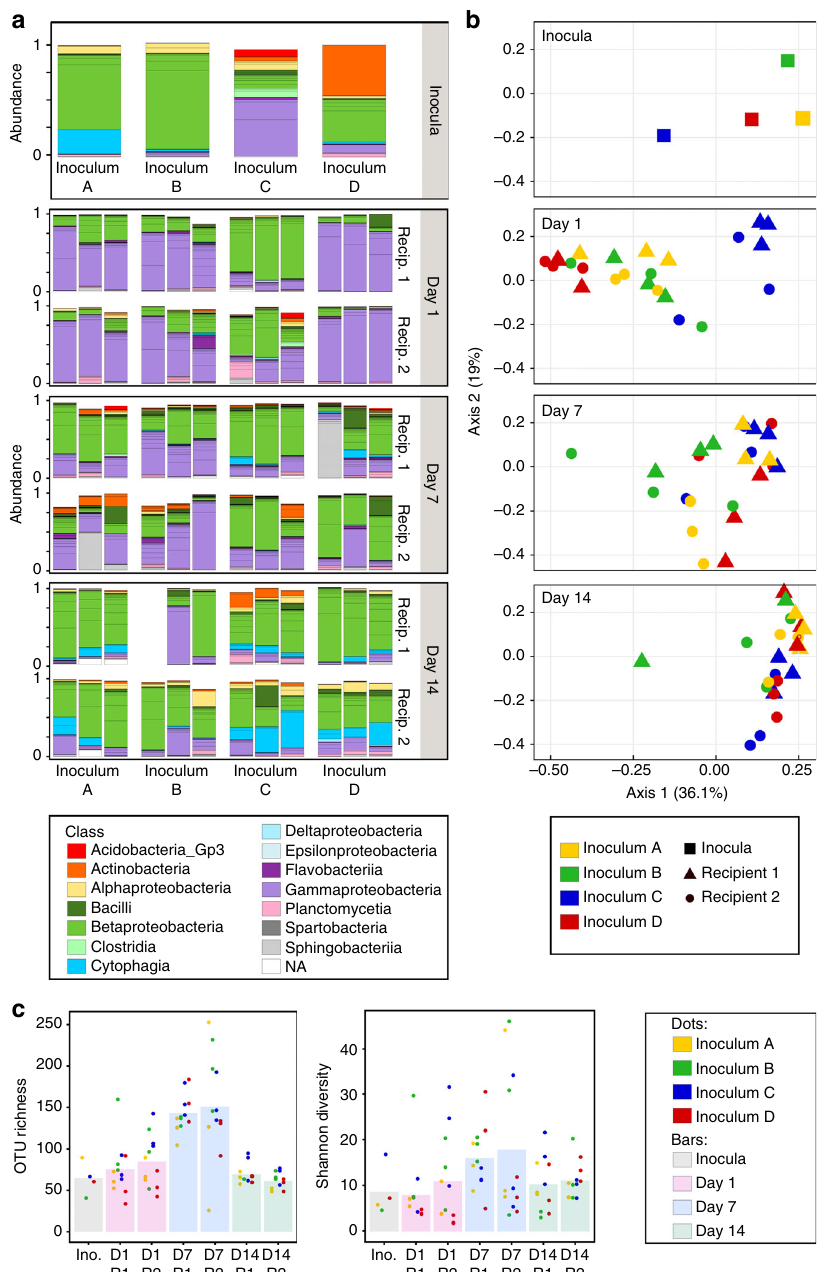
Fig. 5 Host genotype and initial bacterial inoculum interact to shape Daphnia gut microbiota. a Relative abundance of OTUs in inocula ( n = 4) and gut microbiota of recipient Daphnia , 1, 7, and 14 days after the transplant ( n = 72 samples, i.e., 2 recipient genotypes × 4 inocula × 3 biological replicates× 3 time points; microbiota characterization was performed on pools of 10 guts). Colors indicate bacterial classes. OTUs with an occurrence lower than 1% are not represented. b Principal component analysis of microbial communities from inocula and Daphnia gut microbiota, using weighted Unifrac distance. The inocula and the different time points are represented on separate panels to facilitate interpretation. Gut microbiota composition in recipient Daphnia signi fi cantly changed over time ( p = 0.001). At day 1, it was in fl uenced by the inoculum but not by the recipient genotype ( p = 0.001 and 0.062, respectively). At day 14, it was affected by both the inoculum and the recipient genotype ( p = 0.001 for both factors). p values were obtained from permutation MANOVA. c α -diversity (OTU richness and Shannon diversity) in inocula and gut microbiota of recipient Daphnia . Bars indicate mean values, points indicate speci fi c values for each sample. In gut microbiota, OTU richness and Shannon diversity changed over time ( p < 0.0001 and p = 0.012, respectively). OTU richness and Shannon diversity were higher at day 7 than at other time points (day 1 – 7: p < 0.0001 and p = 0.015, respectively;